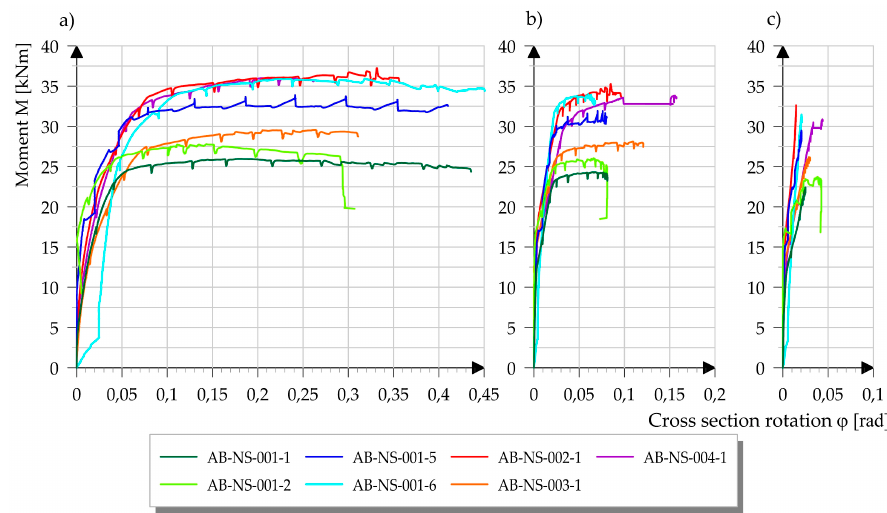
Figure 9. Moment to rotation ratio for monotonously tested column specimens: ( a ) end section; ( b ) section at 150 mm height; ( c ) section at 350 mm height.